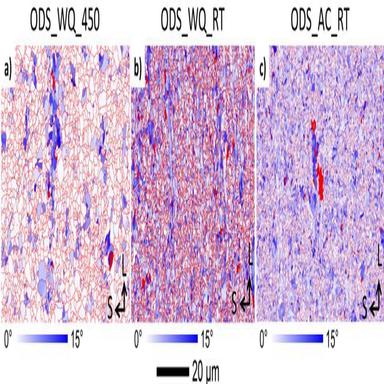
Internal misorientation of a measured pixel with respect to the corresponding average grain orientation of a) ODS_WQ_450 b) ODS_WQ_RT and c) ODS_AC_RT. White colour indicates zero misorientation, transitioning towards blue with increasing misorientation. Red coloured points exceed 15° internal misorientation. (For interpretation of the references to color in this figure legend, the reader is referred to the web version of this article.)